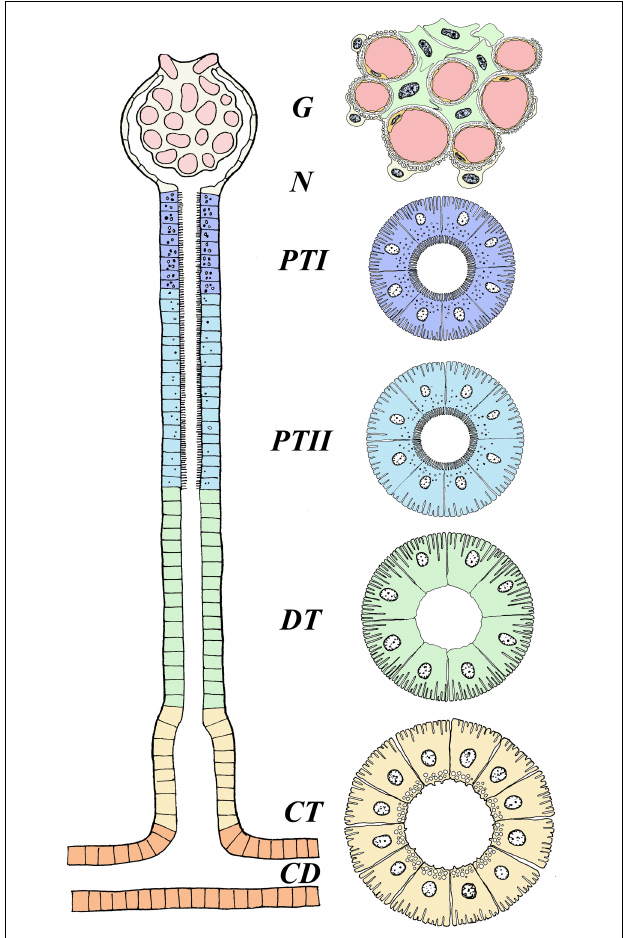
FIGURE 1 | Anatomical overview of the nephron in euryhaline teleosts. The figure represents the general anatomy of the nephron in euryhaline species with the following segments: Glomerulus (G), Proximal Tubule I (PTI), Proximal Tubule II (PTII), Distal tubule (DT) and Collecting tubule (CT). Hence, no cross section overview is given for neck segment (N) and collecting duct (CD). Note that the intermediate segment, only found in FW stenohaline teleosts, is not illustrated. The anatomical differences with well-defined vacuoles and microvilli in the proximal tubule (more distinct in PTI), basolateral membrane infoldings in all tubule segments (more distinct in DT) and apical located membrane granules in CT. Model are based on Hickman and Trump (1969). Further note that this illustrates the main anatomical features of the nephron, and that differences may exists between species. For a more comprehensive detailed anatomical view see Hickman and Trump (1969) and Dantzler